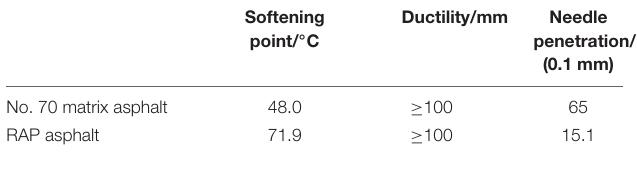
TABLE 3 | Main technical indexes of No. 70 matrix asphalt.